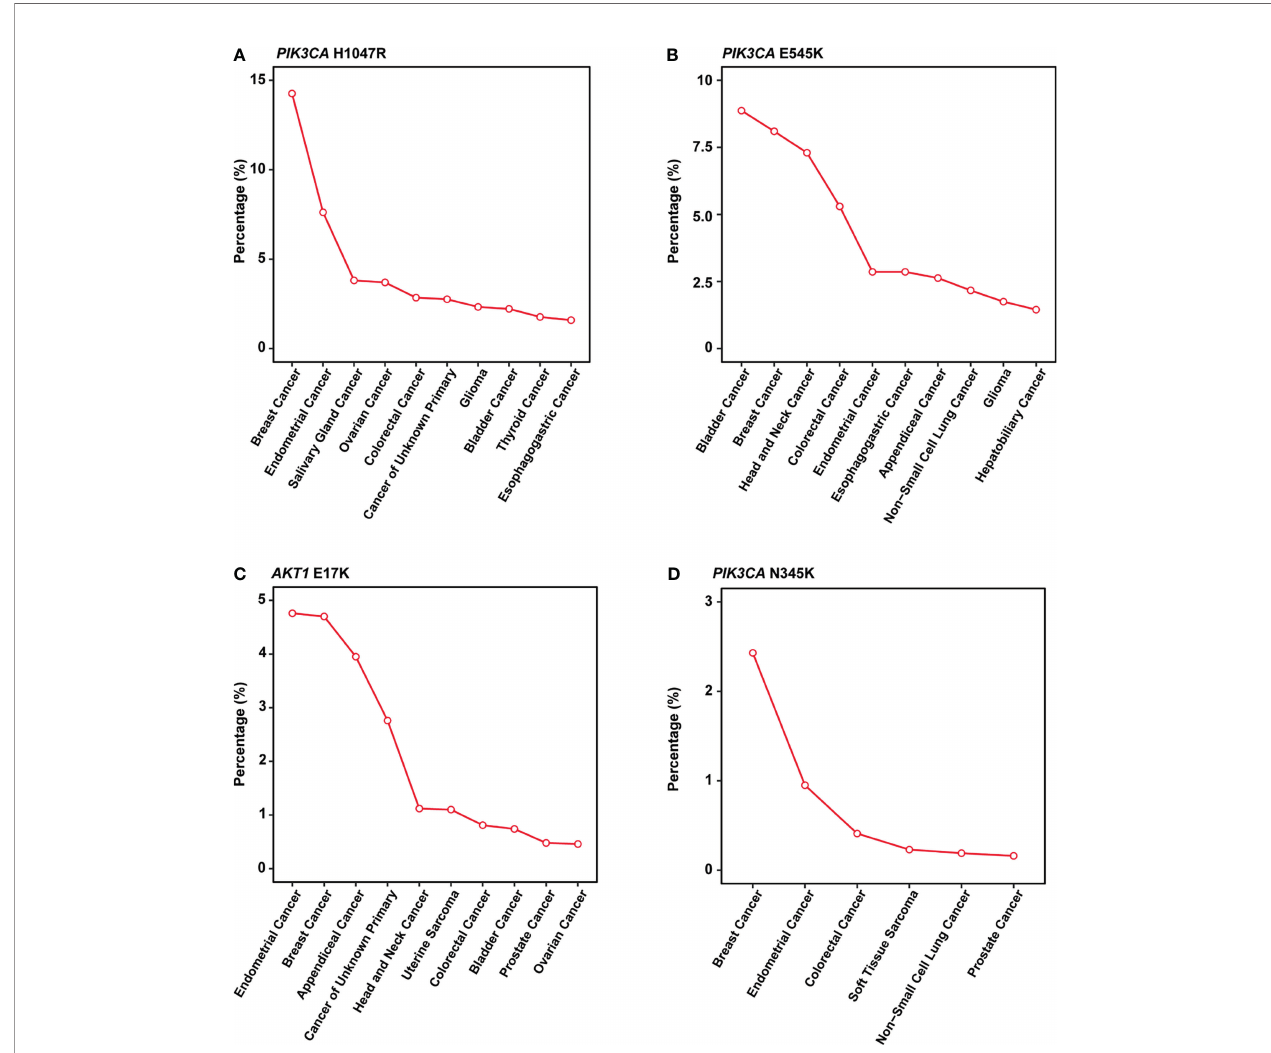
FIGURE 4 | Mutation frequency across multiple cancer types in MSK-IMPACT cohorts. (A-D) Line graph showing the percentage of cancer. (A) PIK3CA H1047R; (B) PIK3CA E545K; (C) AKT1 E17K; (D) PIK3CA N345K. All cancer types shown above should meet the following criteria: 1) with a total number of patients equals or exceed 50 in MSK-IMPACT cohort; 2) mutated frequency of the corresponding mutation should exceed 0; 3) if there are over 10 cancer types, show only the top 10 results with the highest